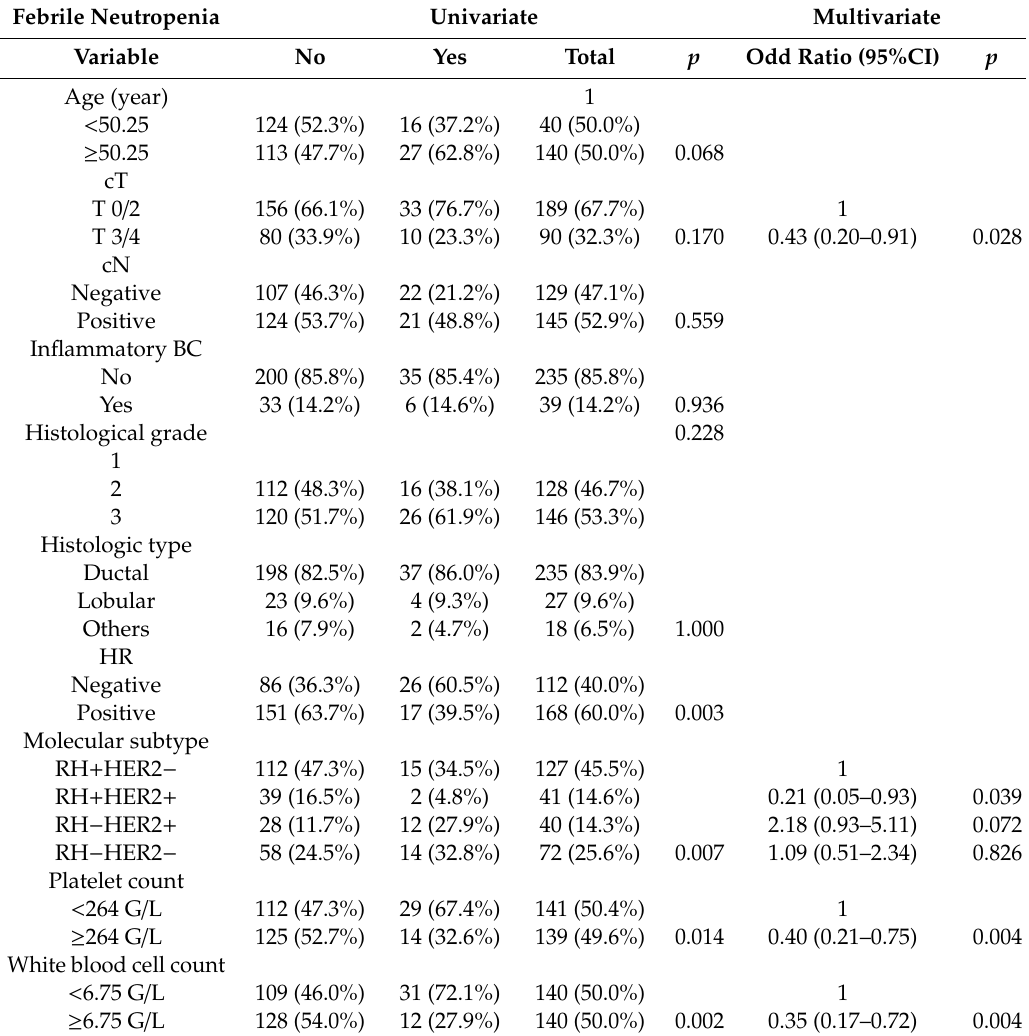
Table 5. Multivariate logistic regression of predictive factors for febrile